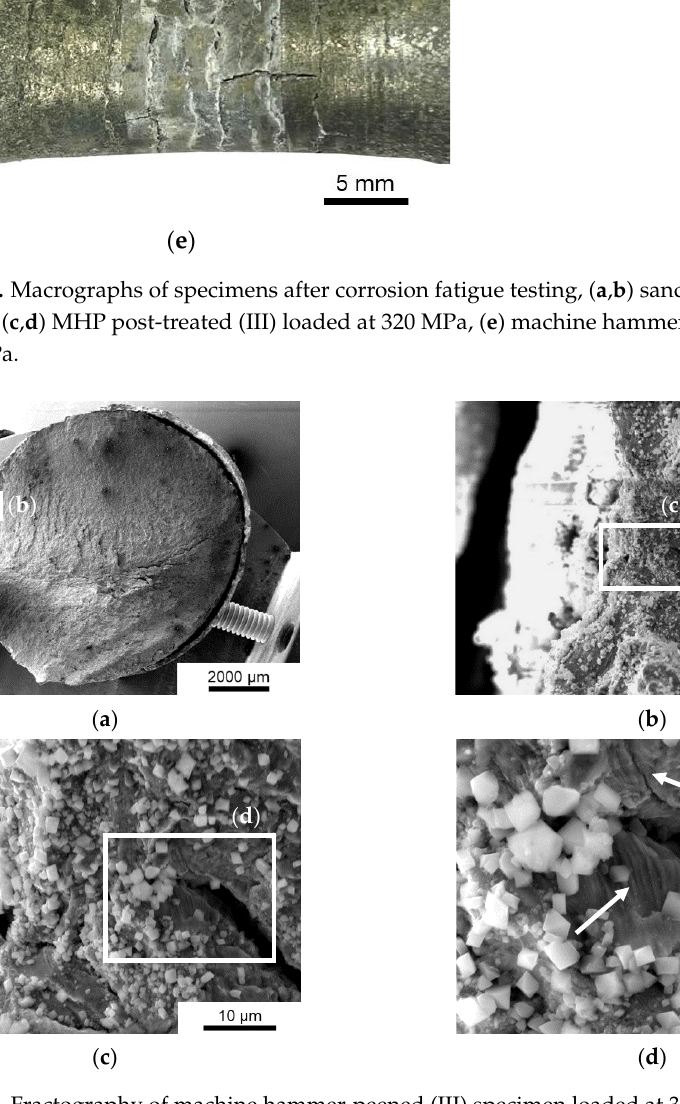
Figure 13. Macrographs of specimens after corrosion fatigue testing, ( a , b ) sandblasted (I) loaded at 320 MPa, ( c , d ) MHP post-treated (III) loaded at 320 MPa, ( e ) machine hammer-peened (III) loaded at 280 MPa.